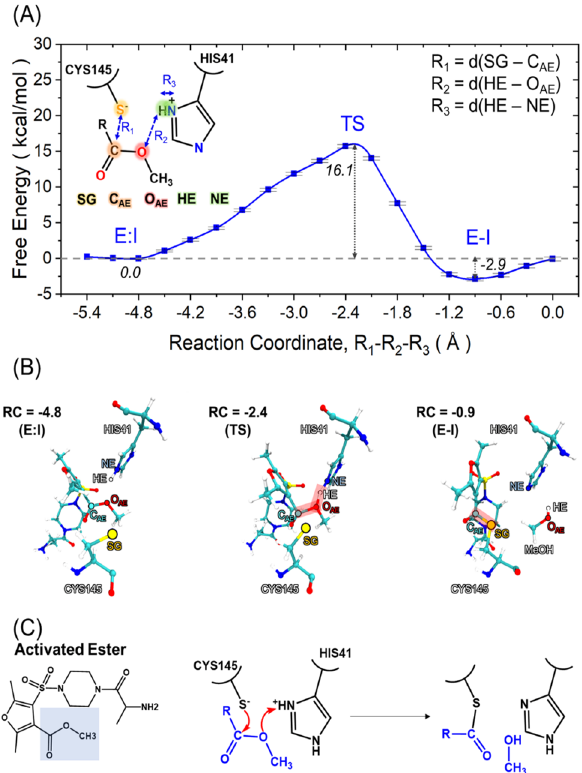
Figure 6. ( A ) Free energy profile of the activated ester inhibitor along the reaction coordinate, R 1 —R 2 —R 3. ( B ) Representative snapshots taken at three different points along the reaction: E:I (left), transition state (middle), and E-I state (right). ( C ) A proposed concerted reaction mechanism from the E:I state to E-I complex of the activated ester